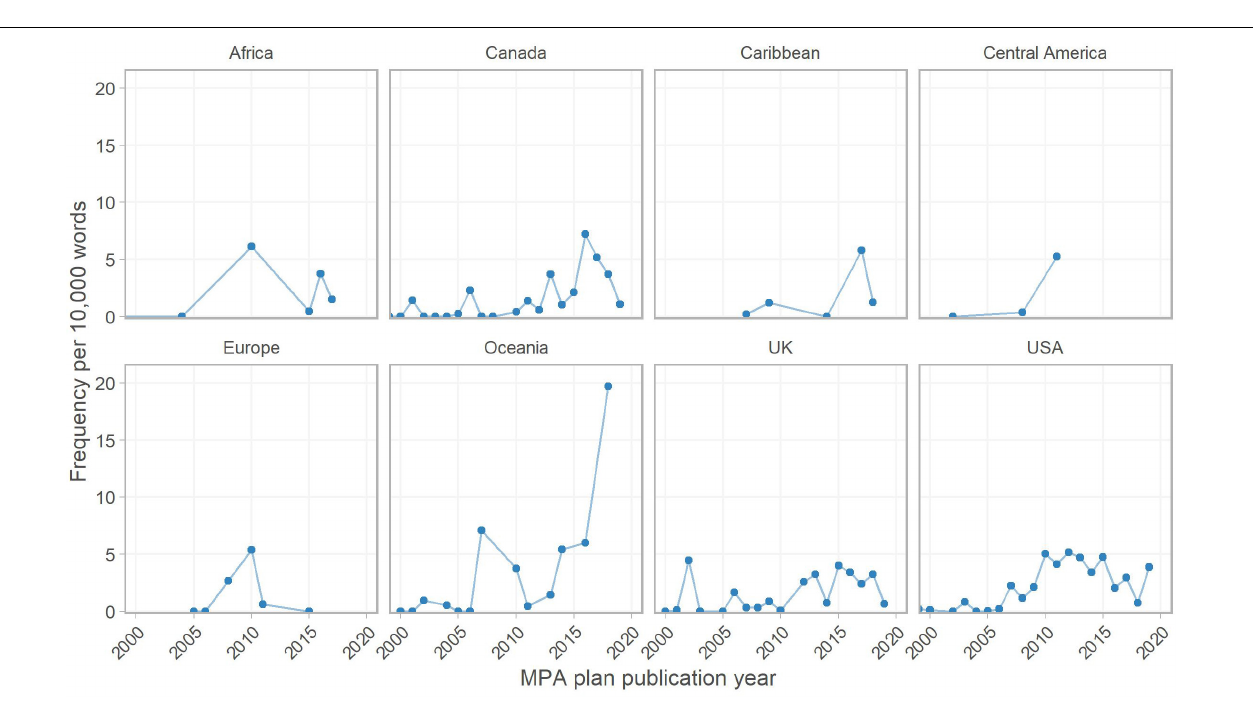
FIGURE 1 | The proportion of MPA management plans in each region that contained the climate change-related terms. Management plans that contained at least one of the five climate change terms were thereafter referred to as climate-considering plans for simplicity.